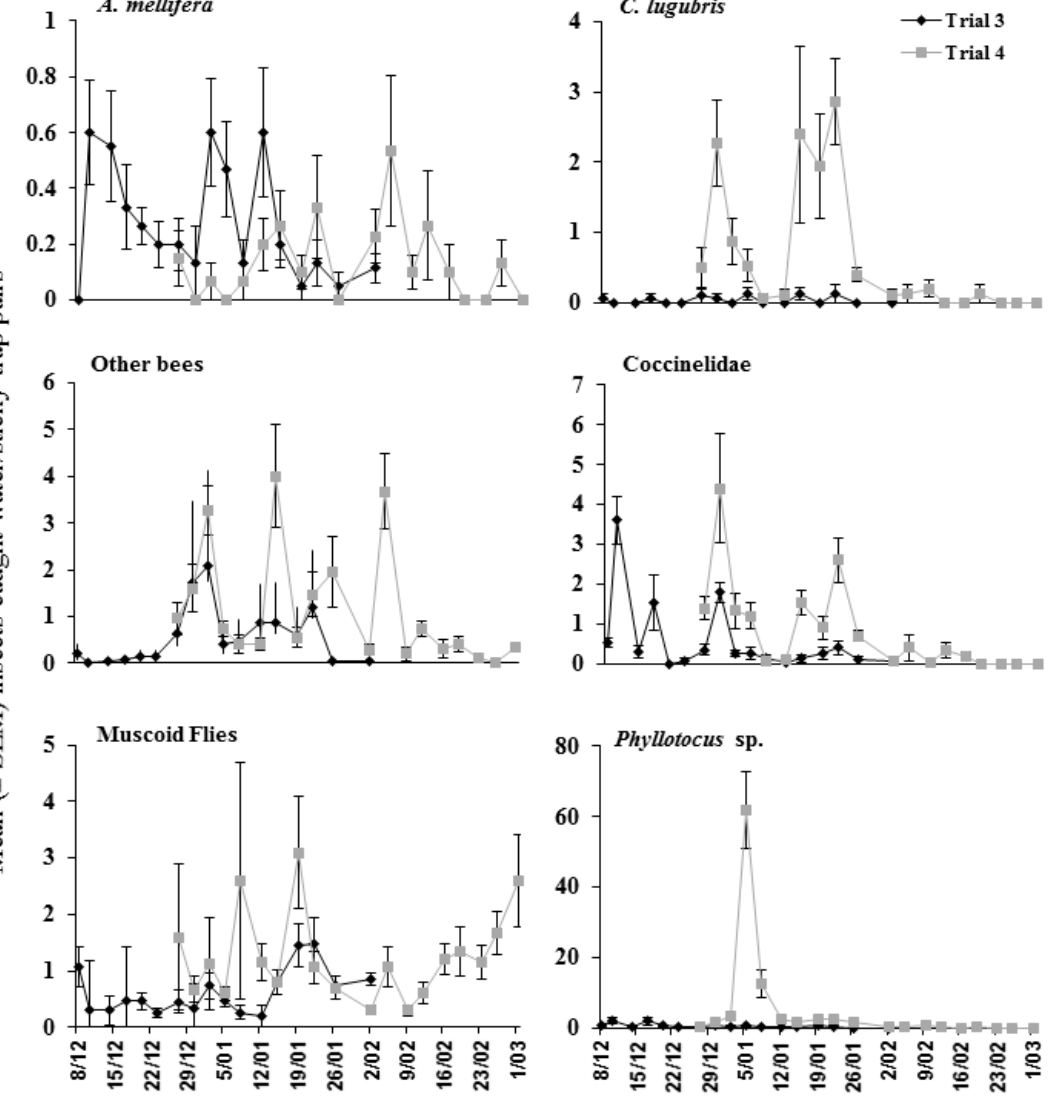
Figure 2. Number of insects (means ± SEM) caught in water traps and sticky traps (data pooled) in trials 3 and 4.